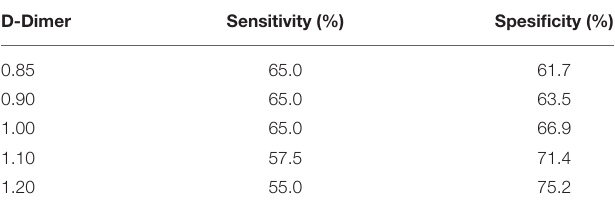
TABLE 3 | Cut-off values of D-dimer for intensive care unit admission state. D-Dimer Sensitivity (%) Spesificity (%)